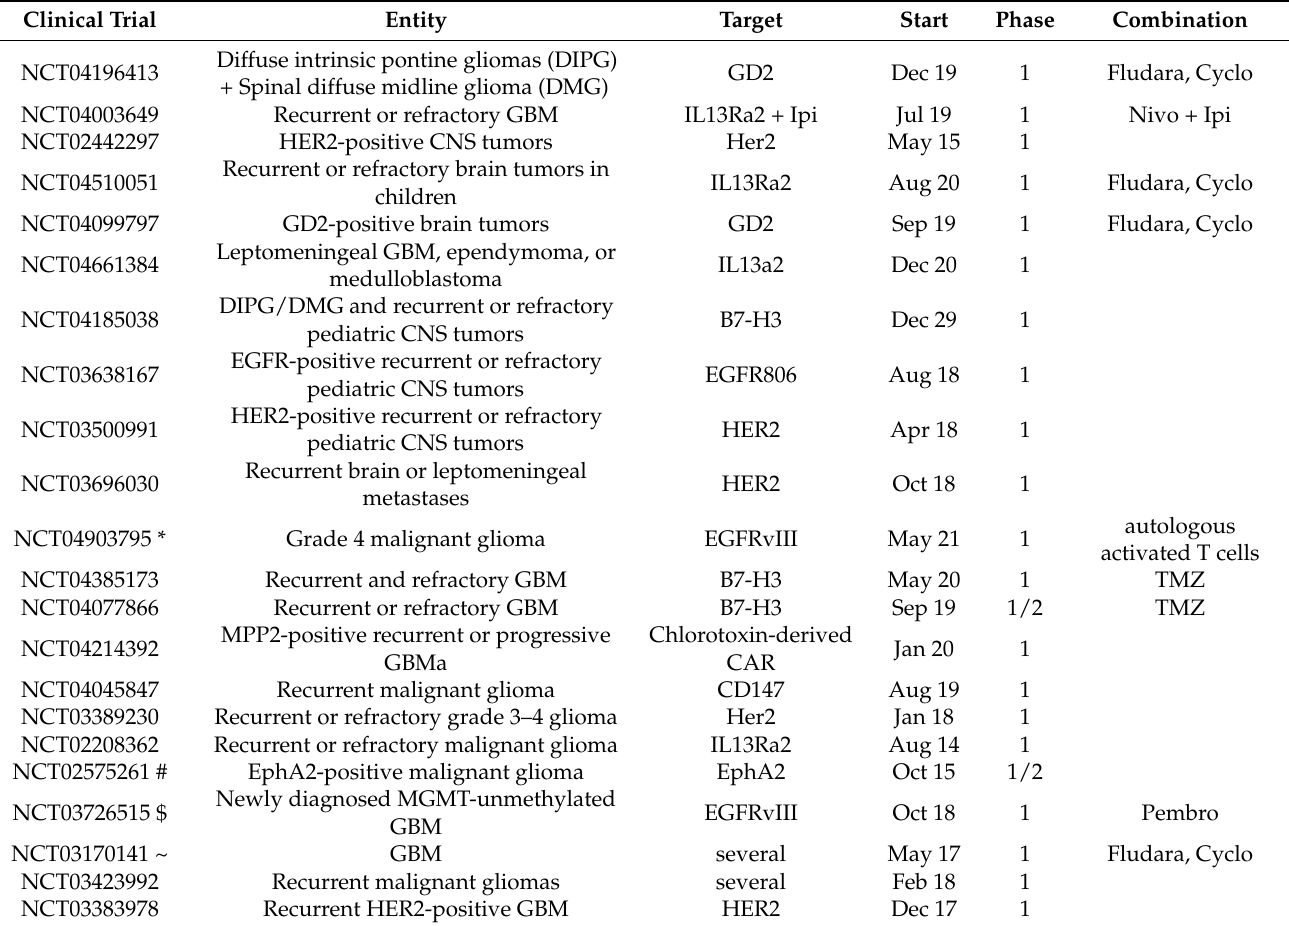
Table 1. Clinical trials investigating genetically modified cellular therapies in brain